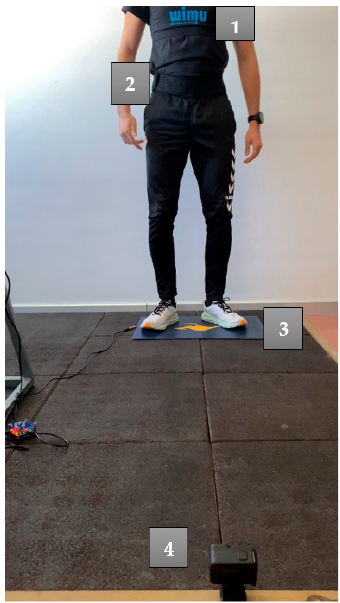
Figure 1. Study setup and locations of the tested devices. ( 1 ) WIMU PRO TM ( 2 ) VERT ® ( 3 ) Chronojump Boscosystem ® ( 4 ) high-speed camera: A GoPro ® HERO9 Black HD . jump Boscosystem ® ( 4 ) high-speed camera: A GoPro ® HERO9 Black